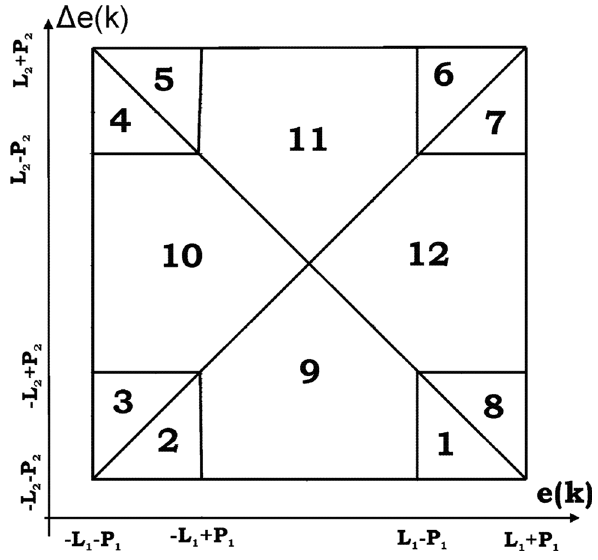
Fig. 6 ICs or the input plane with 0 < 𝜃 1 ∕ 𝜃 2 <